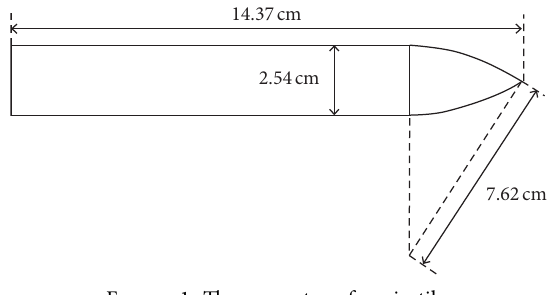
Figure 1: The geometry of